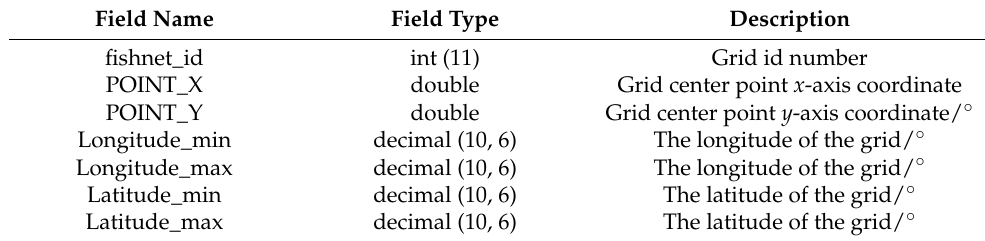
Table 2. Map grid information data.